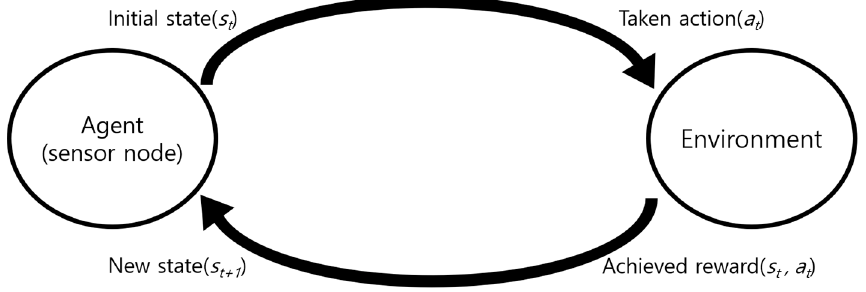
Figure 5. Diagram of Q-learning.